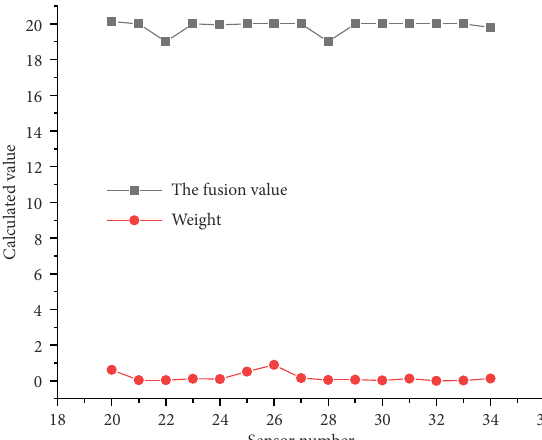
Figure 12. Fusion values and weights by adaptive